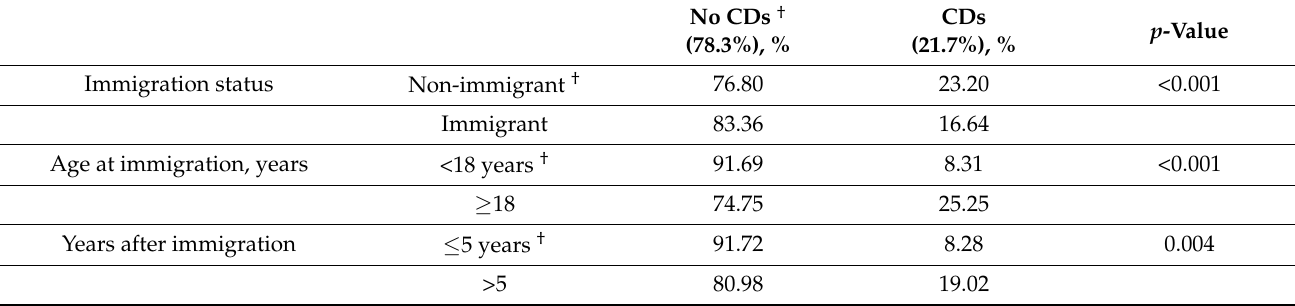
Table 1. Weighted prevalence of chronic diseases by sociodemographic and behavioral characteristics and immigration